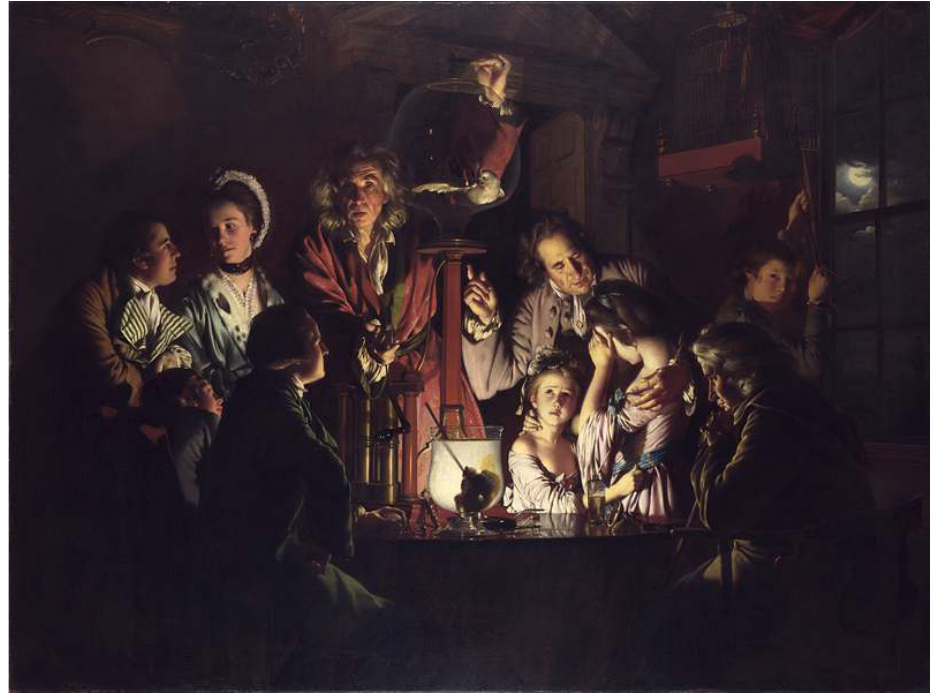
Oil on canvas, 183 x 244 cm, The National Gallery,